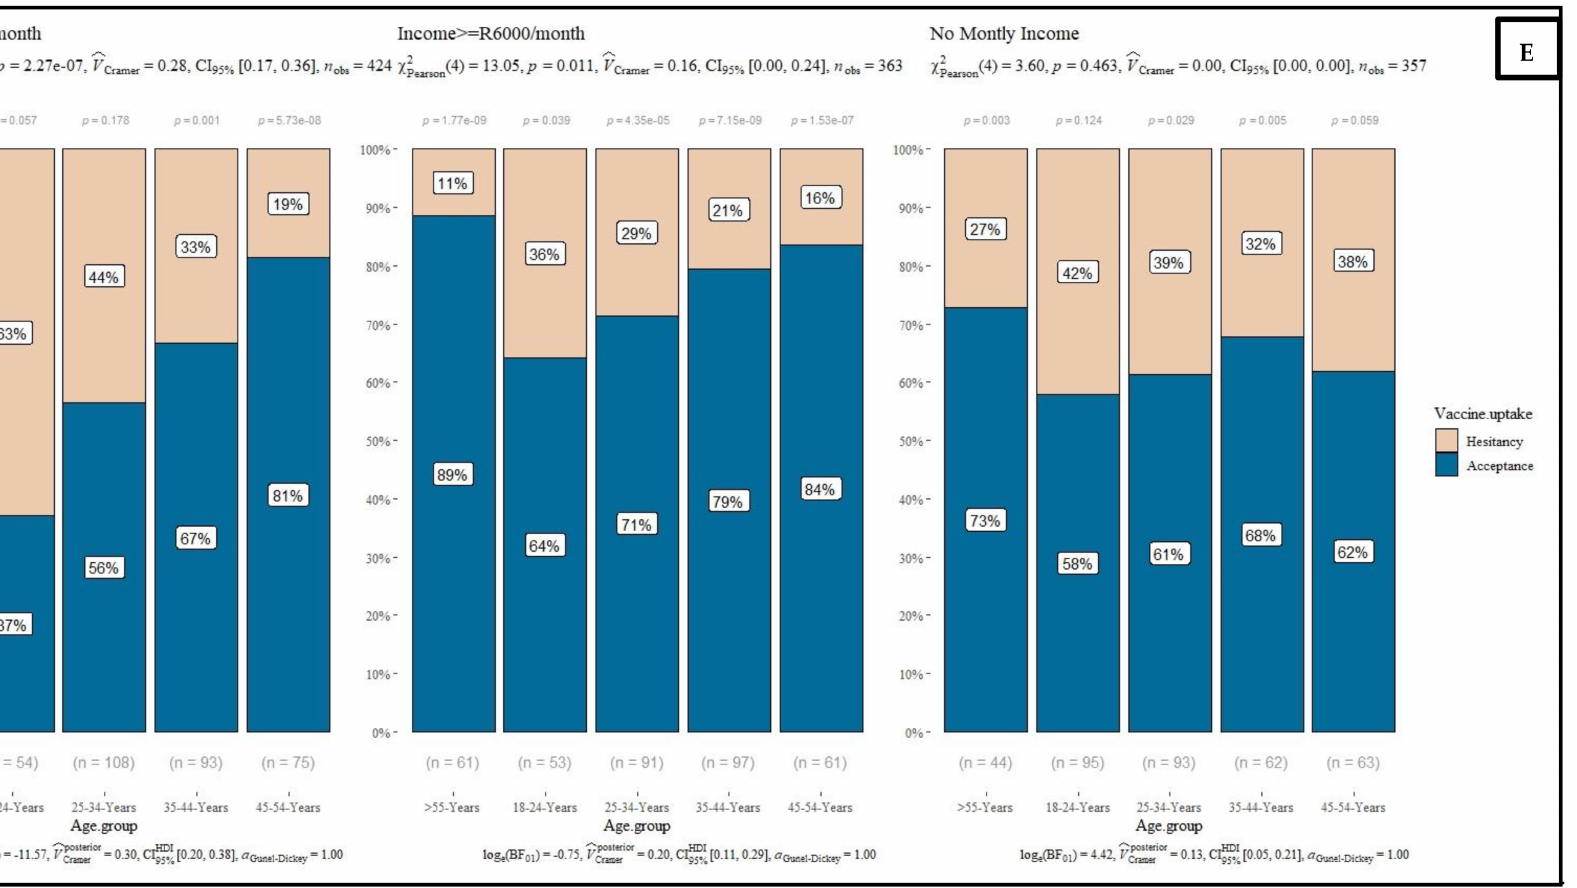
Figure 1. Distribution of COVID-19 vaccine uptake by age groups ( A ) and, by ethnic groups ( B ), by level of concern about side effects ( C ), by ability to access the government online COVID-19 platform ( D ) and by reported monthly income ( E ) among respondents from four local communities in South Africa, from the 6th of June to the 30th